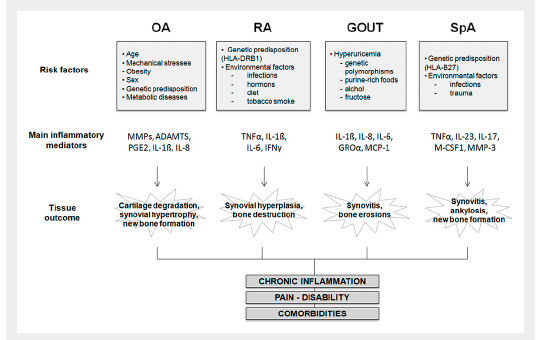
Schematic pathogenesis of most common arthropathies. Several risk factors are implicated in the development of osteoarthritis, rheumatoid arthritis, gout and spondyloarthritis. Each of these diseases is characterised by the release of specific inflammatory mediators which mainly lead to joint destruction, pain, disability, chronic inflammation and co-morbidities. ADAMTS = a disintegrin and metalloproteinase with thrombospondin motifs; GRO = growth regulated oncogene; HLA = human leucocyte antigen; IFN = interferon; IL = interleukin; M-CSF = macrophage colony-stimulating factor; MMPs = metalloproteinases; OA = osteoarthritis; PGE = prostaglandin E; RA = rheumatoid arthritis; RANKL = Receptor activator of nuclear